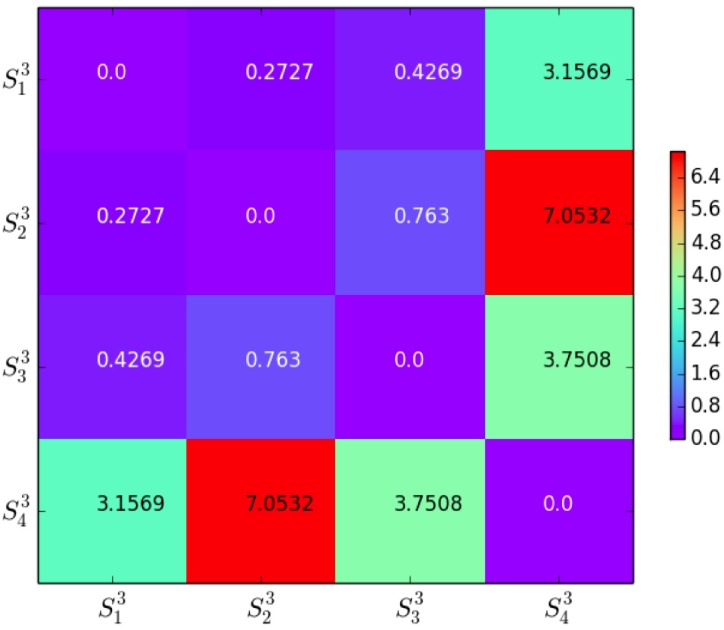
3-dim clusters and TrLogDet distance per dimension.